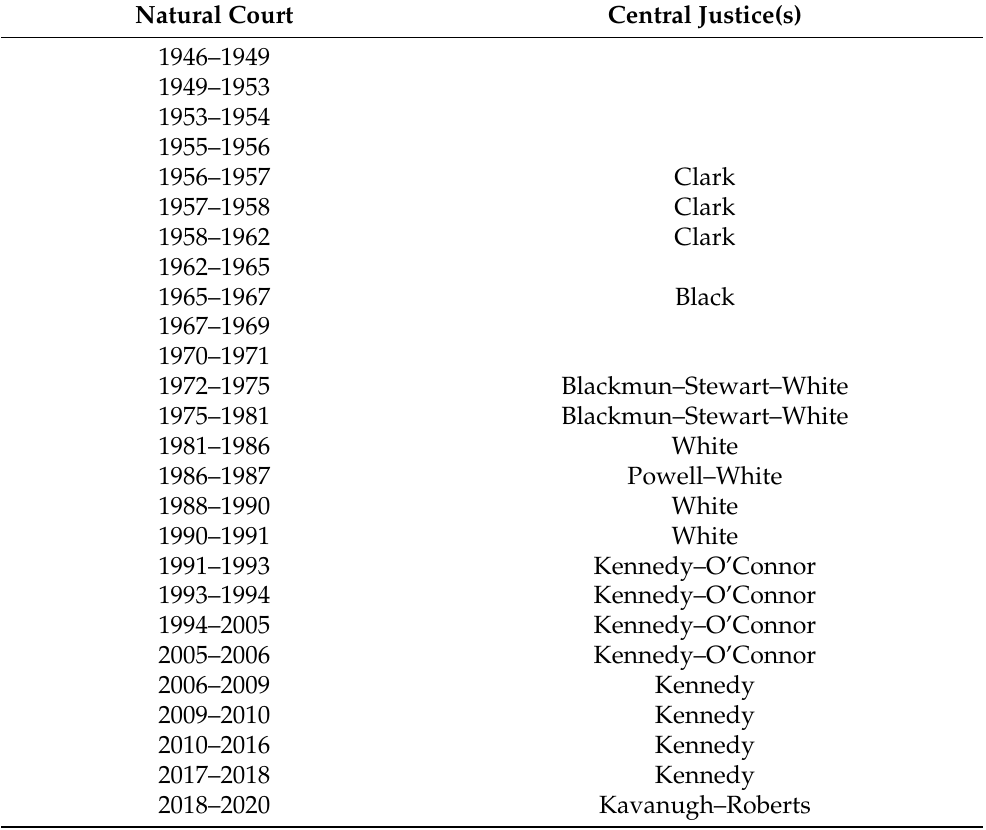
Table 1. The tree-based central justice(s) for each fully staffed natural court in the modern